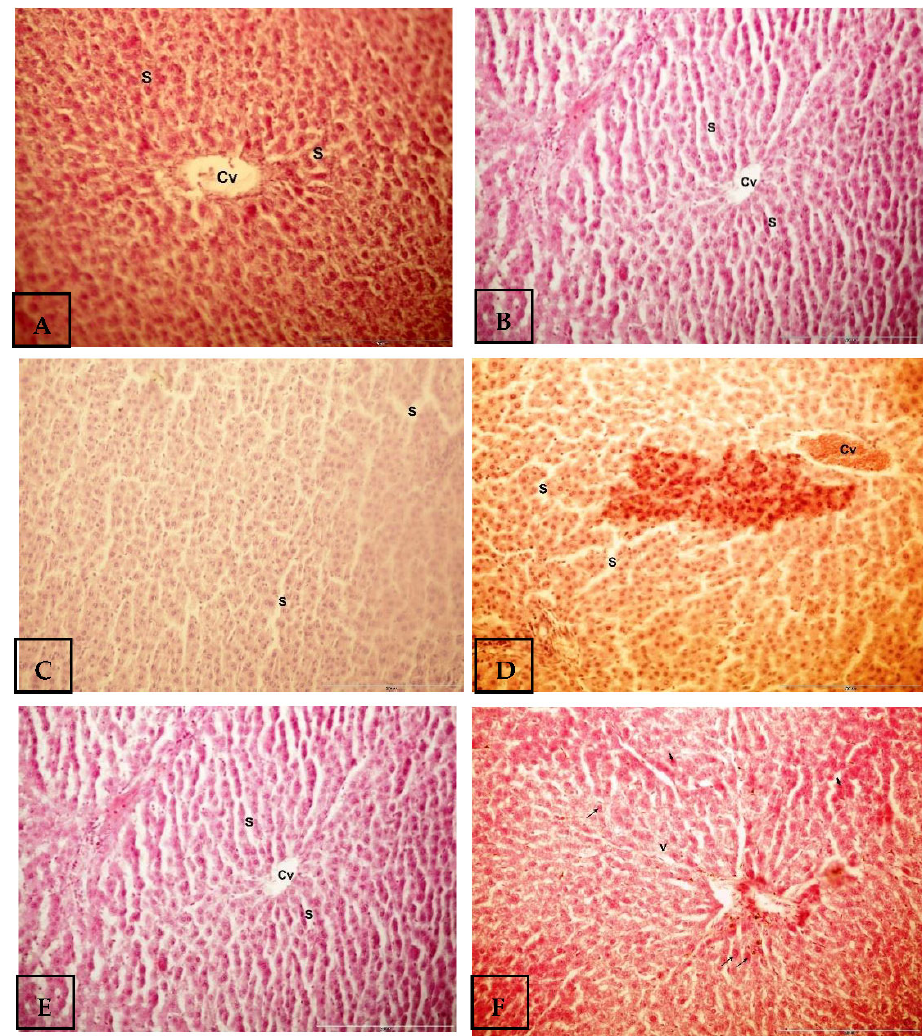
Figure 4. Histopathological changes in female rats stained with hematoxylin and eosin liver tissue samples under magnification 40X. ( A ) Sham control, ( B ), vehicle control, ( C , D ) induction group, ( E ) protection group, and finally, ( F ) treatment group. Cv: central vein, S: sinusoids, arrows: vacuolated nuclei.